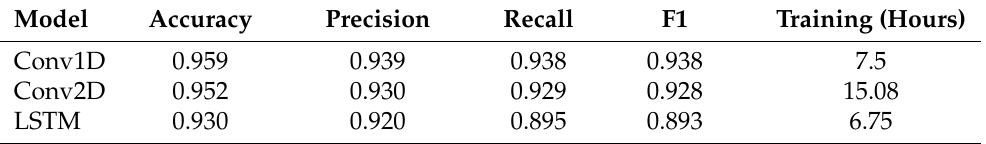
Table 4. Performance evaluation and training time required by all three models with 3.4 s split time.